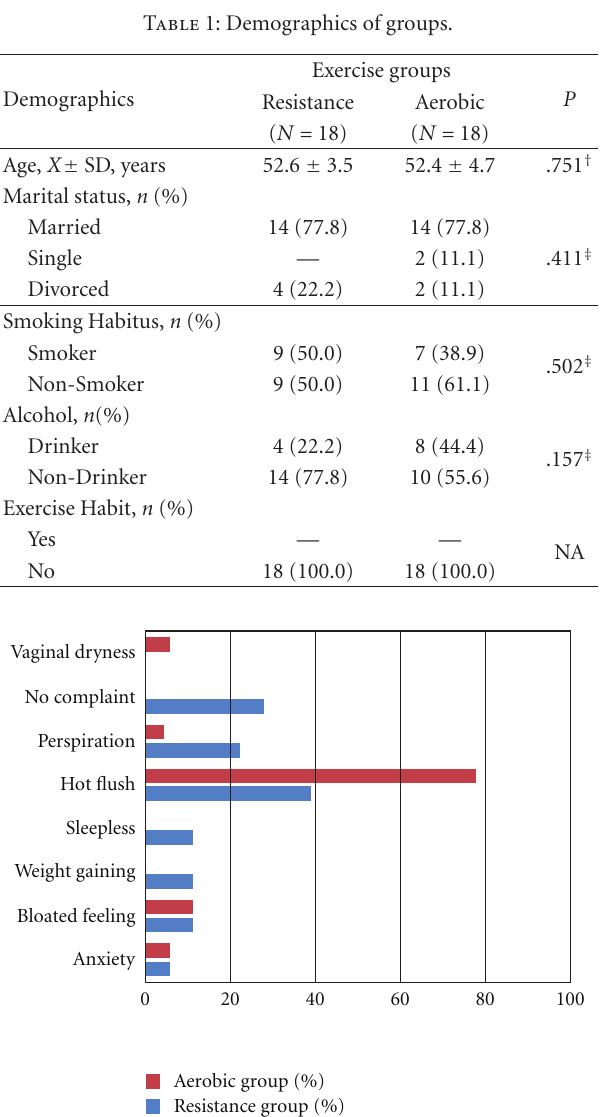
Figure 1: Most serious complaints of cases in resistance and aerobic exercise groups in postmenopausal period.